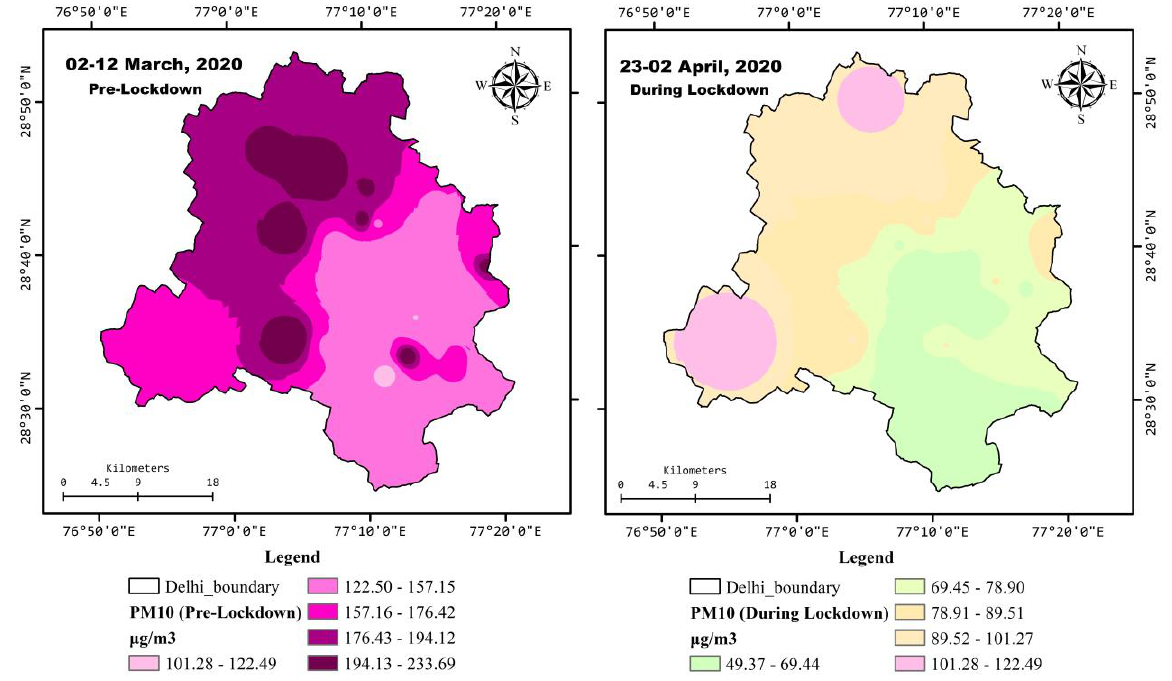
Figure 6. Distribution of PM 10 pollutants before (12-22 March, 2020) and during the lockdown (23 March – 02 April, 2020). It must be noted that only one class overlapped between the two periods of analysis, i.e., 101.28 – 122.49. This class has been provided the same color scheme in pre-lockdown period and during lockdown period maps. It must be noted that pre-lockdown period PM10 ranged from 101.28 to 233.69 μg/m 3 . In contrast, during lockdown, it went down and ranged from 49.37 to 122.49 μg/m 3 .